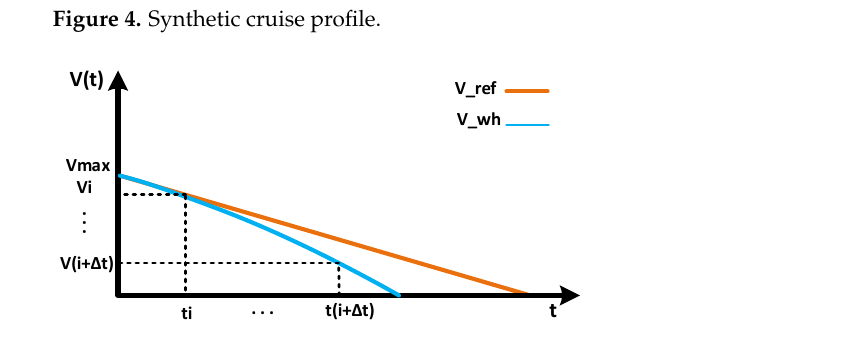
Figure 4. Synthetic cruise profile.